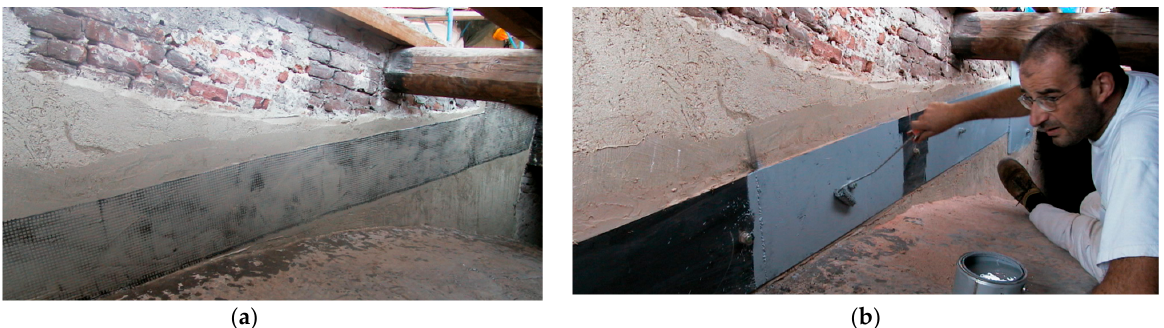
Figure 22. Composite steel-FRP tie: ( a ) carbon-fiber reinforcement; ( b ) steel plate.